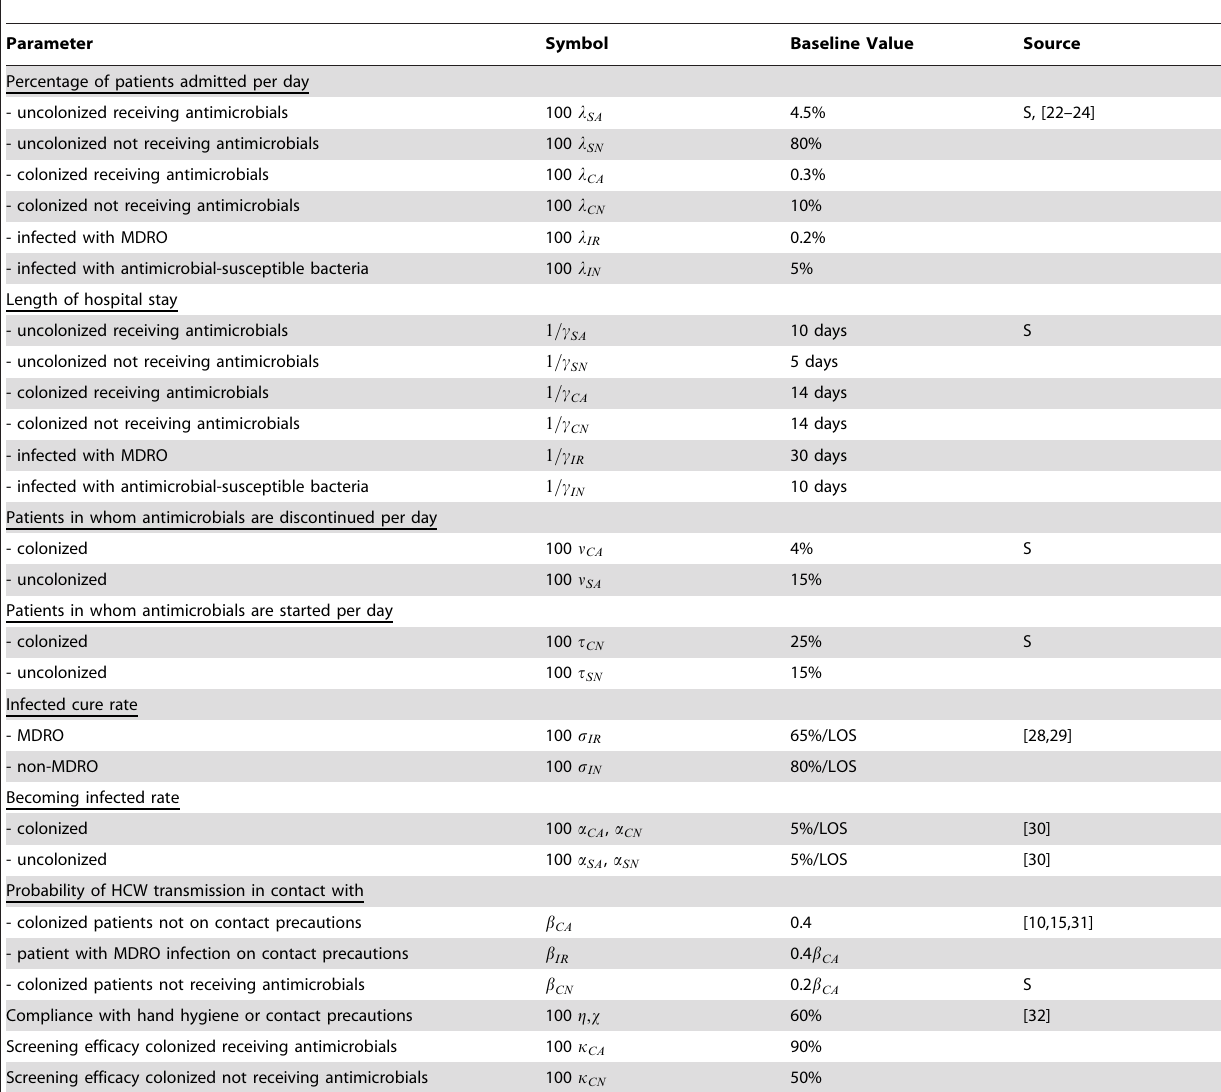
Table 1. Parameter estimates for the model of transmission dynamics of multidrug-resistant organisms